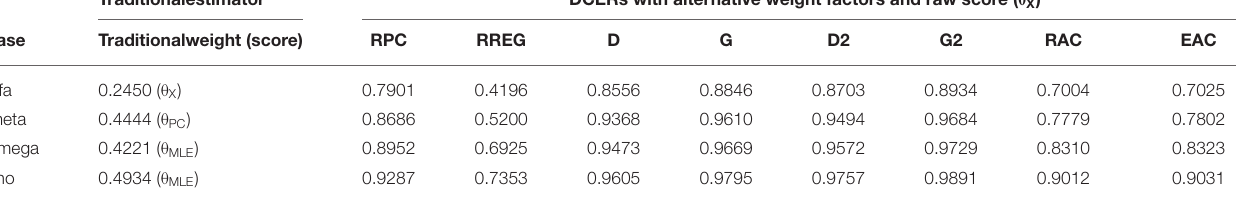
TABLE 3e | Estimates of reliability. Traditionalestimator DCERs with alternative weight factors and raw score ( θ X